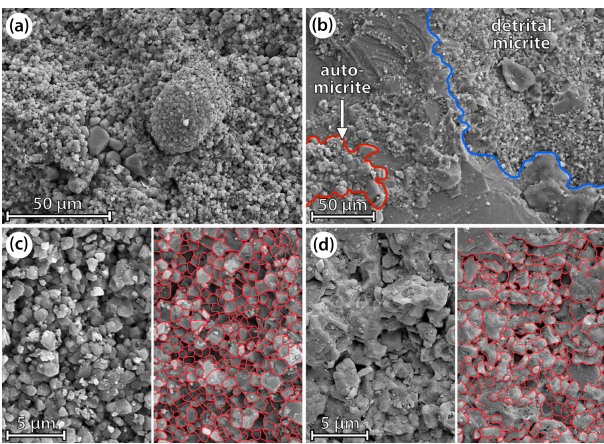
Figure 2. SEM photomicrographs of automicrite versus detrital mi- crite. (a, c) Automicrite of microencruster-dominated facies from the Kanfanar Unit (22.4m and 27.6m; note homogenous crystal size). (b) Automicrite (outlined in red) and detrital micrite (out- lined in blue) of the Dvigrad Unit (2.8m). (d) Detrital micrite of the Dvigrad Unit (2.8m; note variable crystal